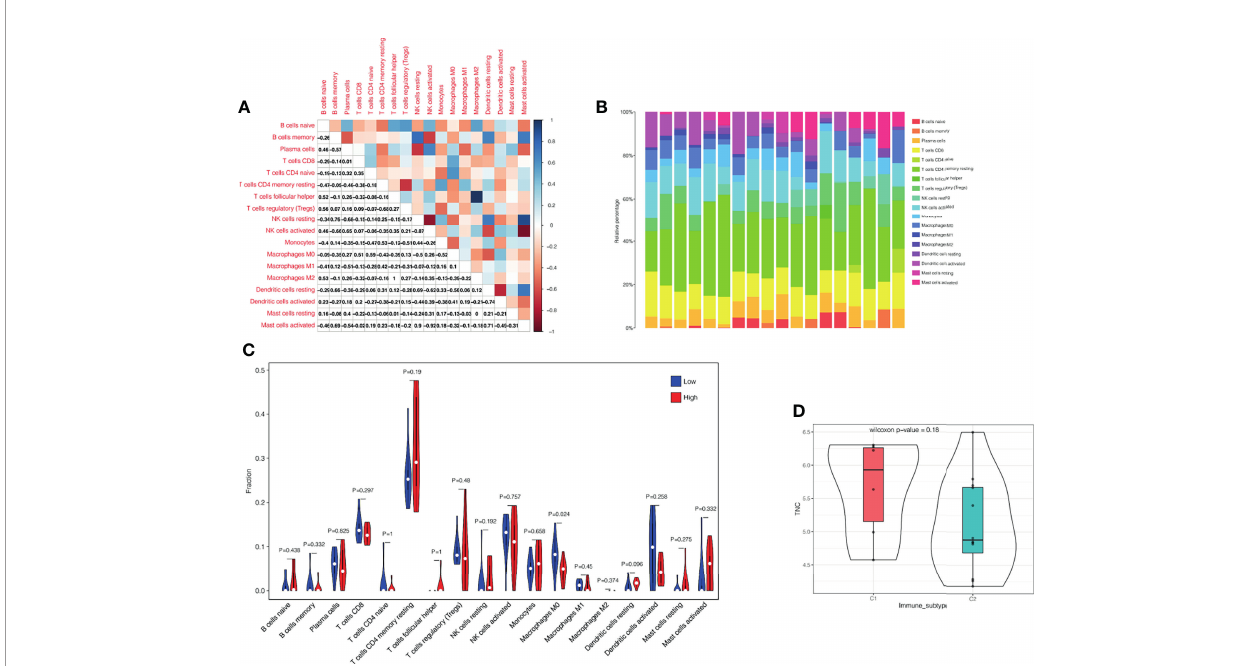
FIGURE 8 | Immune in fi ltration analysis. (A) Correlation analysis of different immune cells. The darker the red, the stronger the negative correlation, and the darker the blue, the strongest positive correlation. (B) The immune landscape of keloid. The proportion of T cells in keloid immune microenvironment is the highest. (C) According to the expression of TNC, we divided them into TNC high expression group and TNC low expression group. The in fi ltration level of macrophage M0 was different between the two groups. (D) Correlation analysis of immune subtypes and TNC. TNC showed a high expression trend in the C1 immune subtype, but the difference was not statistically signi fi cant (P=0.18), which might be related to the small sample size.